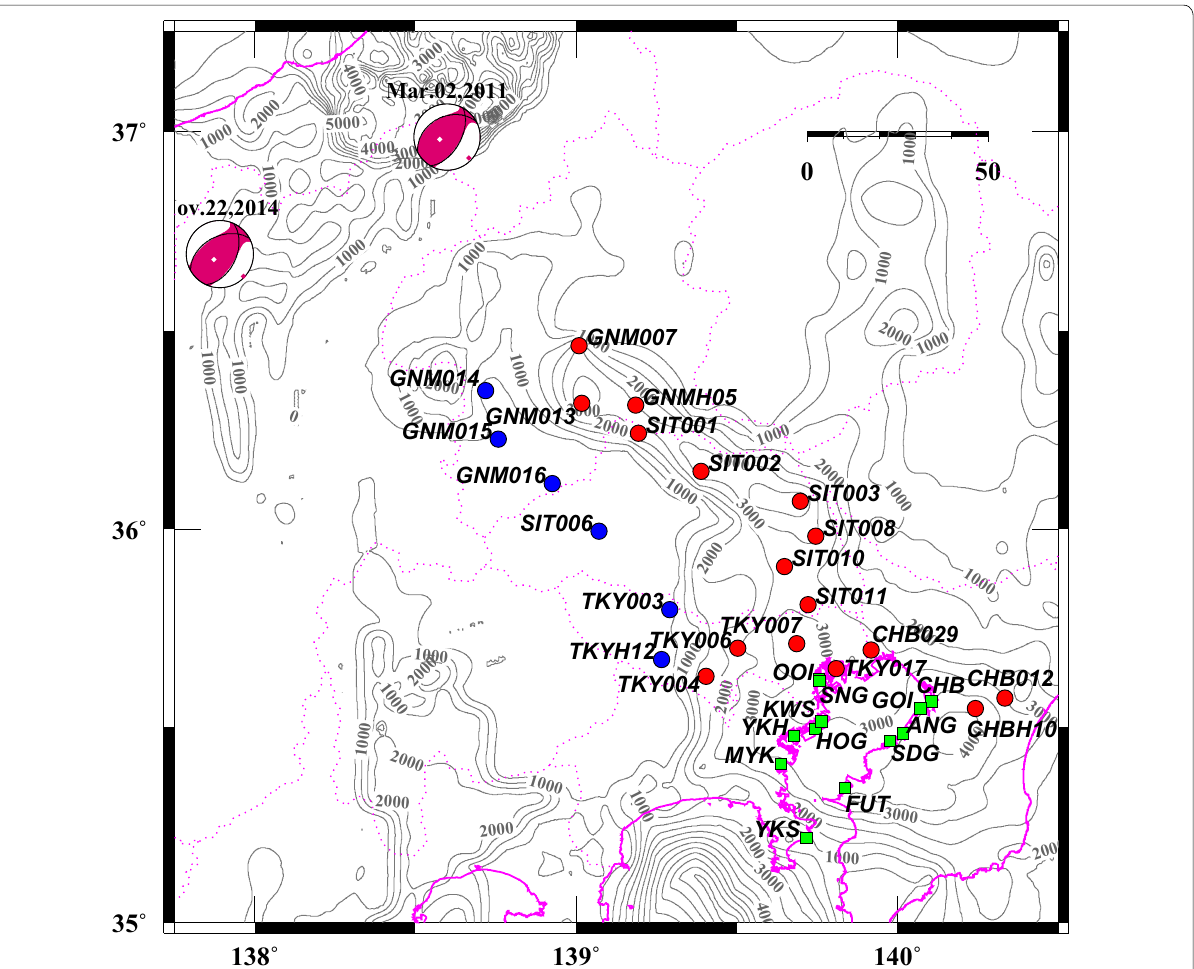
Fig. 2 Locations of the strong motion observation stations used in this study. Green squares indicate the Tokyo Electric Power Company Holdings stations. Circles indicate K-NET and KiK-net stations (Okada et al. 2004). Red circles show the stations located in the basin area, and blue circles show the stations located outside the basin. Characters next to each mark indicate the station code. Dashed purple lines show the prefectural borders in Japan. Gray contour lines indicate the depth of seismic bedrock from the “Japan Integrated Velocity Model version 1” (Koketsu et al. 2012). Event source mechanisms are the moment tensor solutions from F-net (Okada et al.